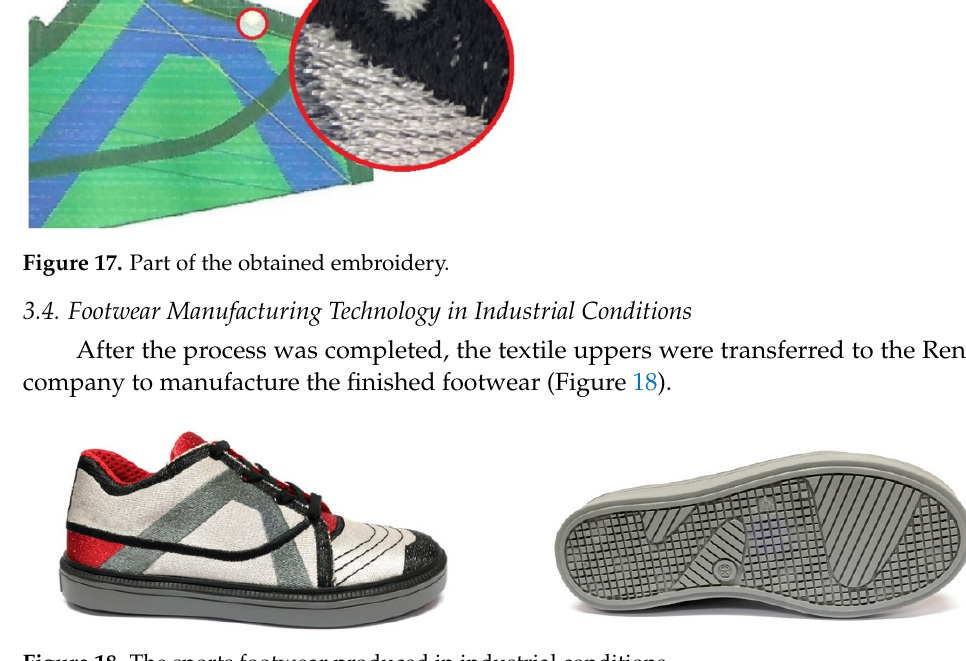
Figure 16. The embroidery design for the footwear elements obtained in the DG program by Pulse .